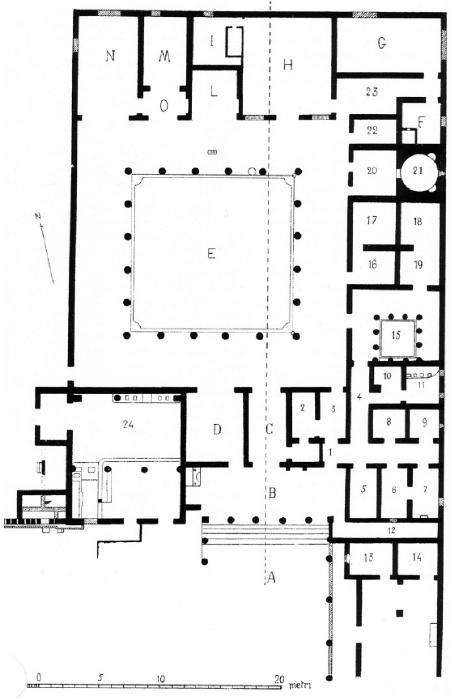
Figure 3. Ground plan of the Villa of Boscoreale; Repro from Barnabei 1901.